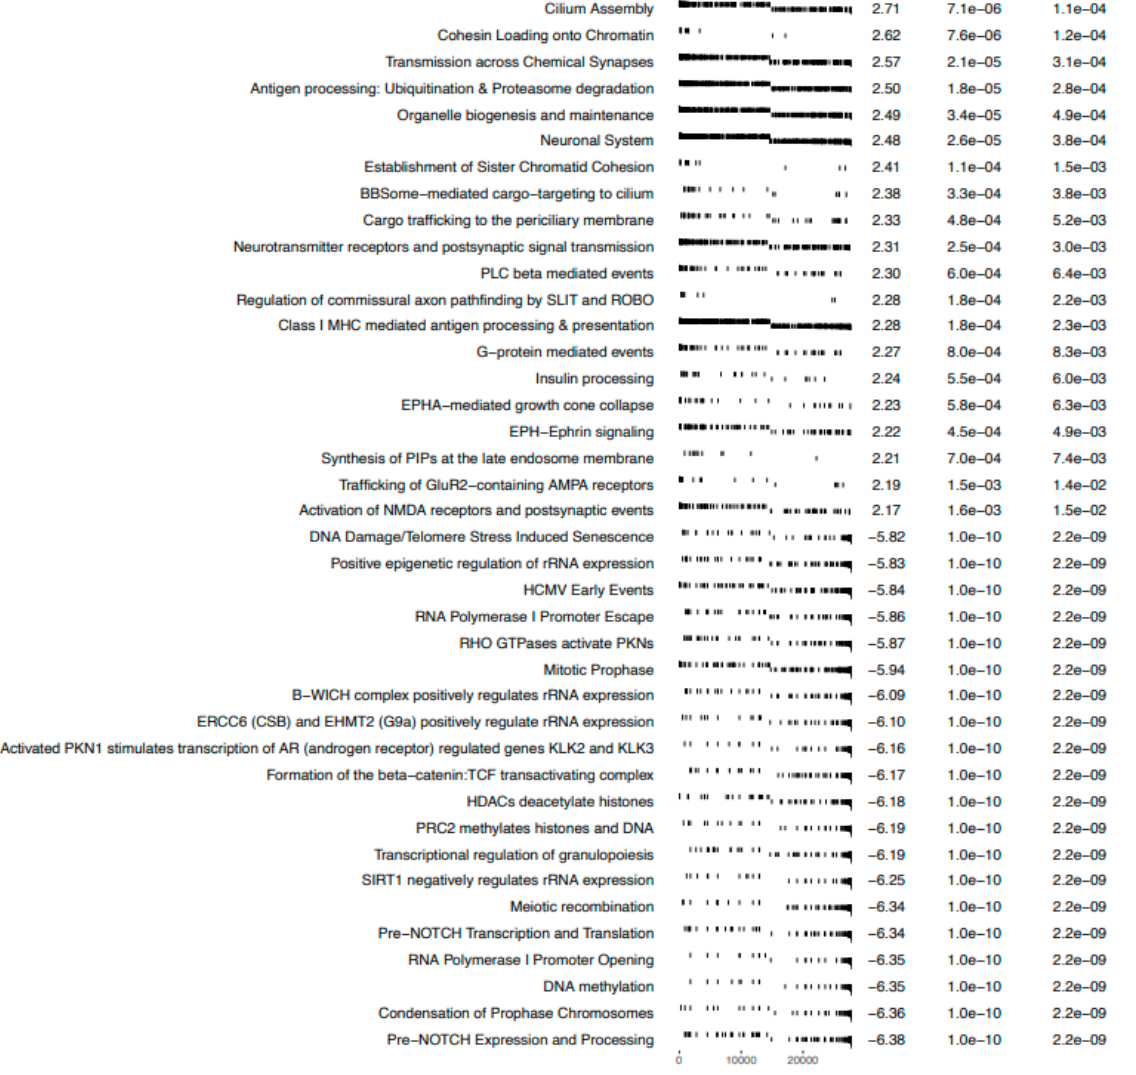
Figure 4. GSEA in BTZ-treated dLUHMES cells. Gene sets are ranked according to the normalized enrichment score (NES).